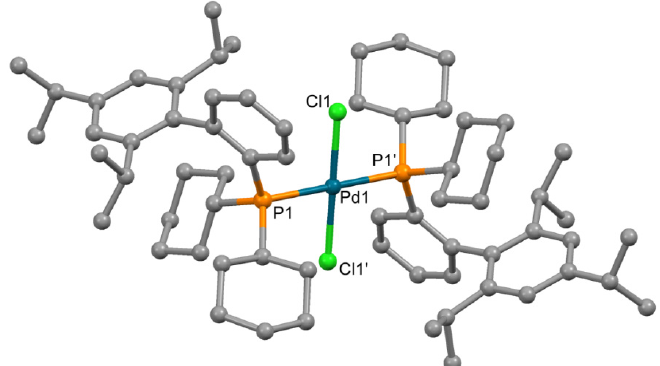
Figure 5. Molecular structure of 4 . Non-coordinated chloroform is not shown Thermal ellipsoids are shown at 0.15 probability level. H atoms are omitted for clarity. Table 3. Selected bond length and angles in 4.